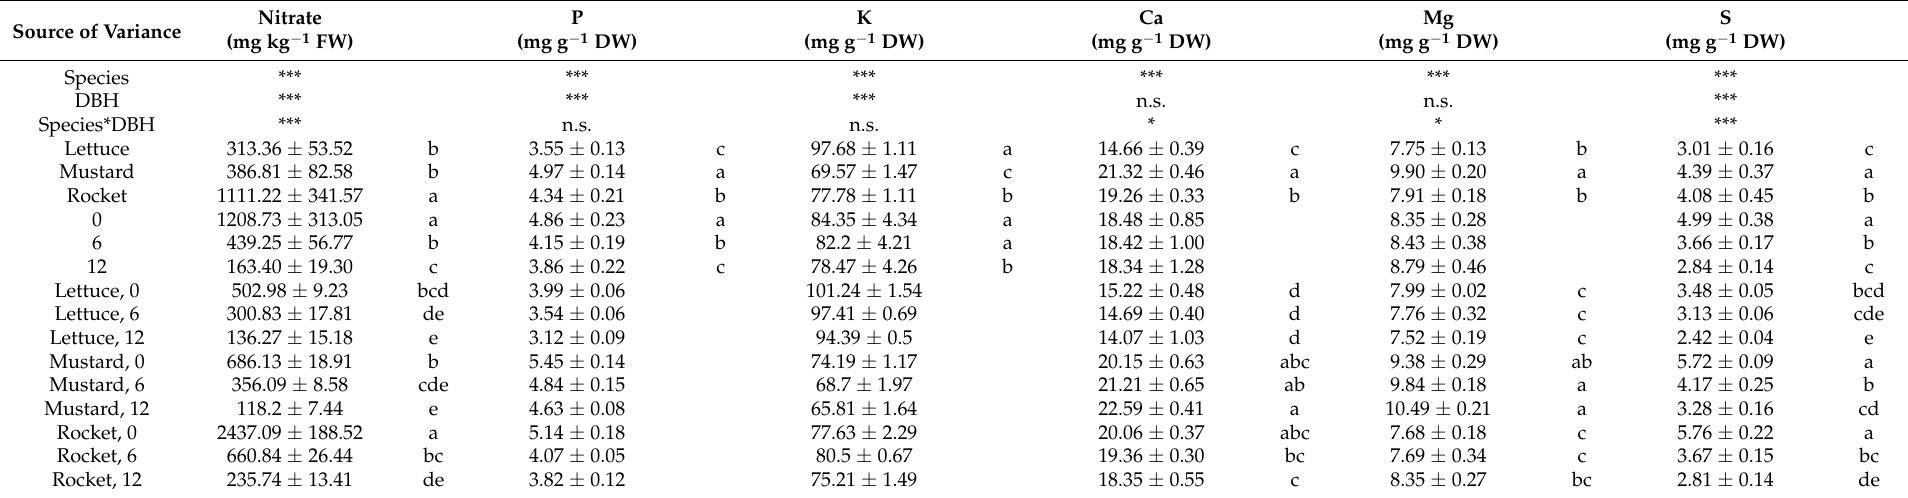
Table 3. Nitrate and mineral content of three microgreen species (lettuce, mustard, and rocket) in response to nutrient deprivation treatment (DBH) applied for 6 or 12 days before harvest. All data are expressed as mean ± standard error, n =